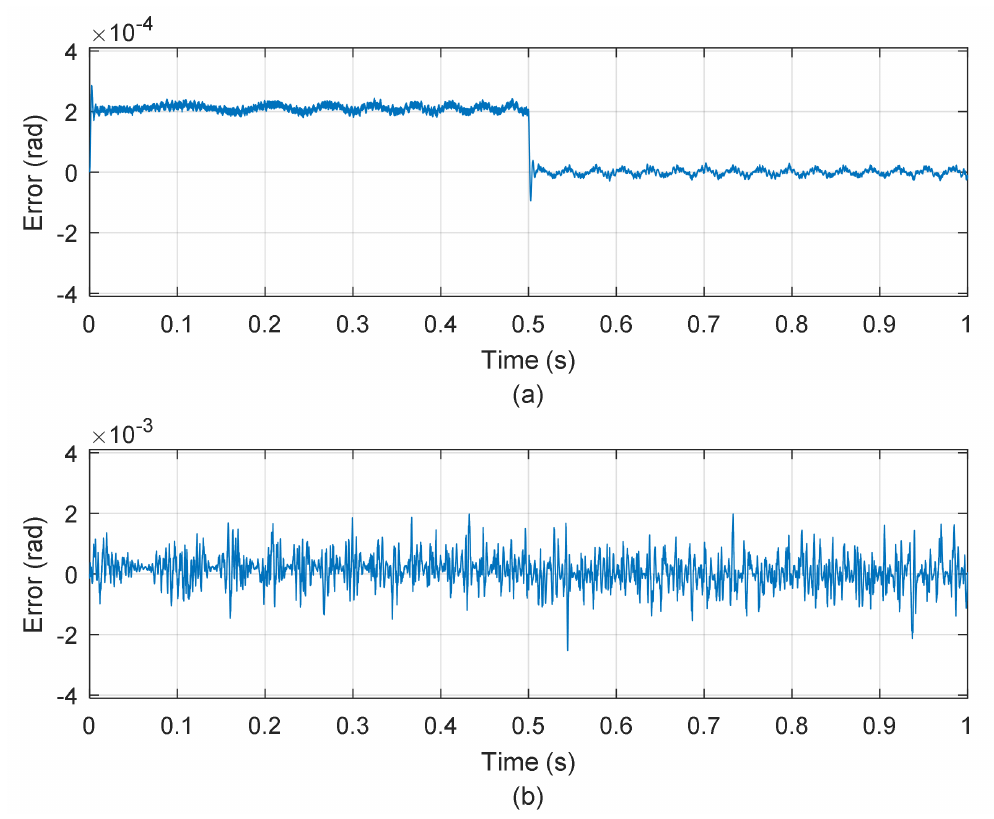
Figure 18. Experimental results for the PI-based ATO. ( a ) Without noise; ( b ) with noise.